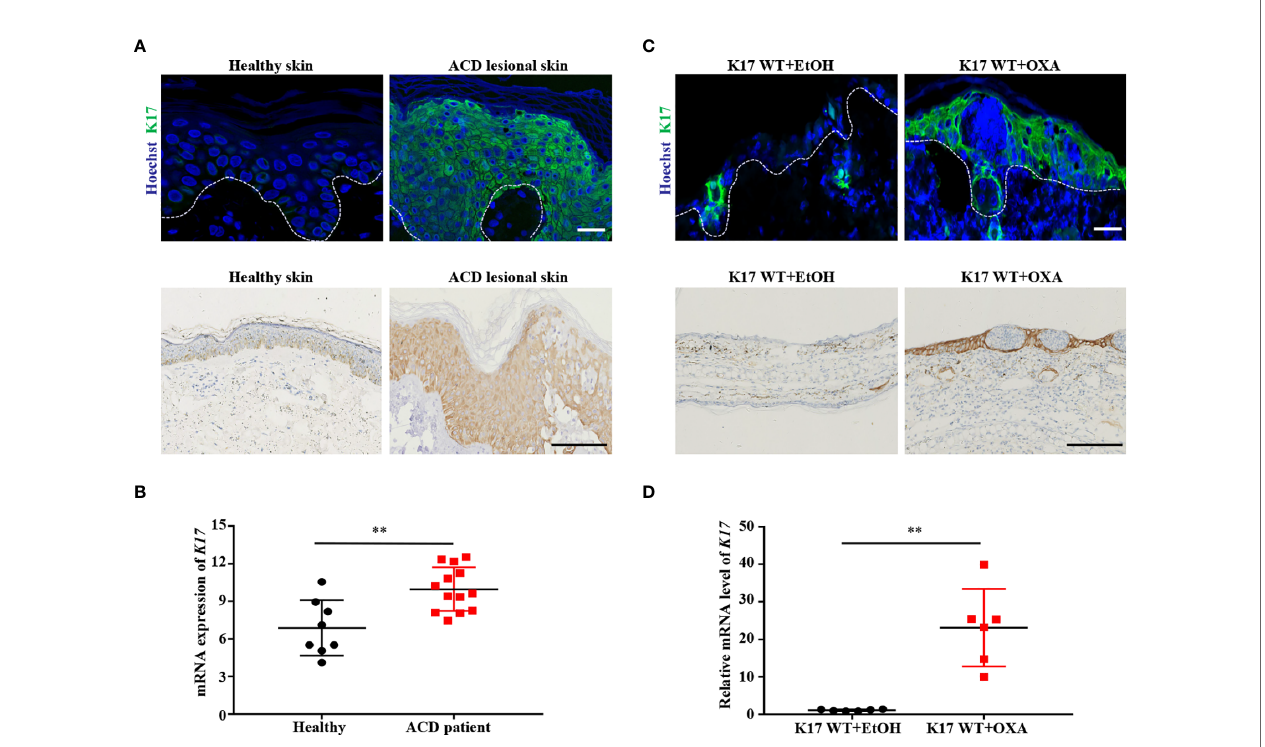
FIGURE 1 | K17 expression is increased in the lesional skin of ACD patients and OXA-induced mice. (A) Immuno fl uorescence and IHC staining of K17 in the lesional skin of ACD patients ( n = 5) and healthy controls ( n = 5). K17 (green) and Hoechst (blue). Scale bar, 10 m m (upper panel) and 100 m m (lower panel). (B) The gene expression pro fi le in the GEO dataset (GDS2935) was analyzed for the expression of K17 in both ACD patients ( n = 13) and healthy controls ( n = 8). (C) Immuno fl uorescence and IHC staining of K17 in ear sections from OXA-induced mice, with ethanol used as a control. n = 5 per group. K17 (green) and Hoechst (blue). Scale bar, 10 m m (upper panel) and 100 m m (lower panel). (D) Relative mRNA expression of K17 in mouse ear skin specimens was analyzed by qRT-PCR at 24 h after OXA challenge. Data represent the mean ± SD ( n = 6) ** p < 0.01. All the bars represent at least average of three independent